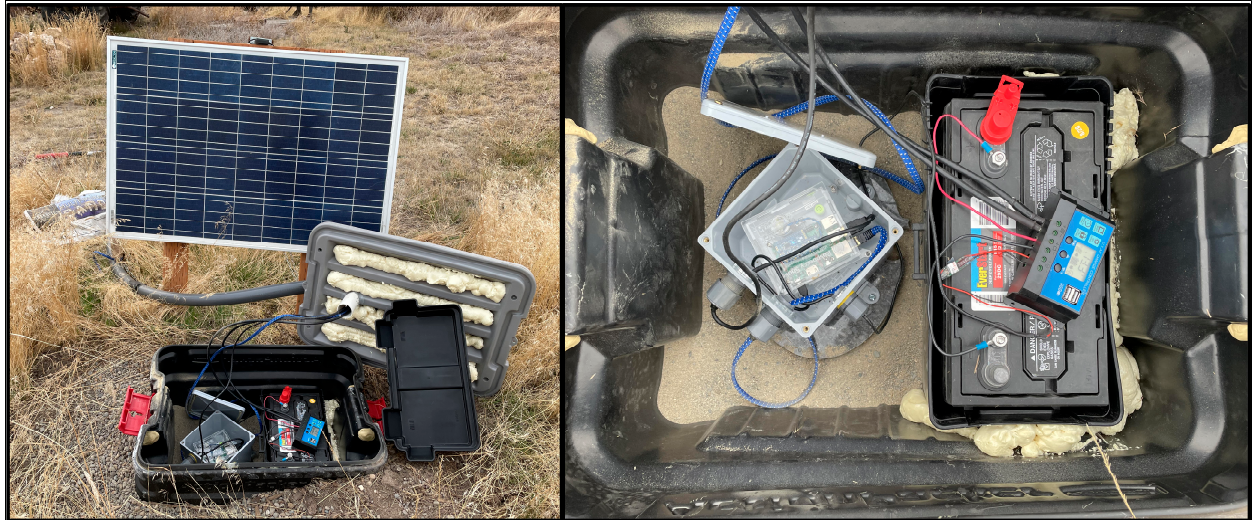
Figure 4. Seismic station composed of the buried, sealable container with solar panel and an inner view of the container with the marine battery and weatherproof case containing the seismometer.